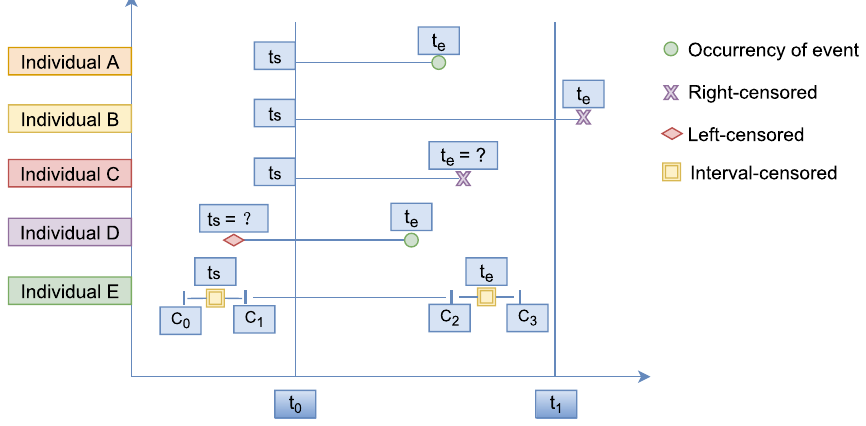
Figure 2. Illustrations of different censoring types. Individual A is a complete record, individual B and C are right-censored, individual D is left-censored while individual E is both left- and right-interval